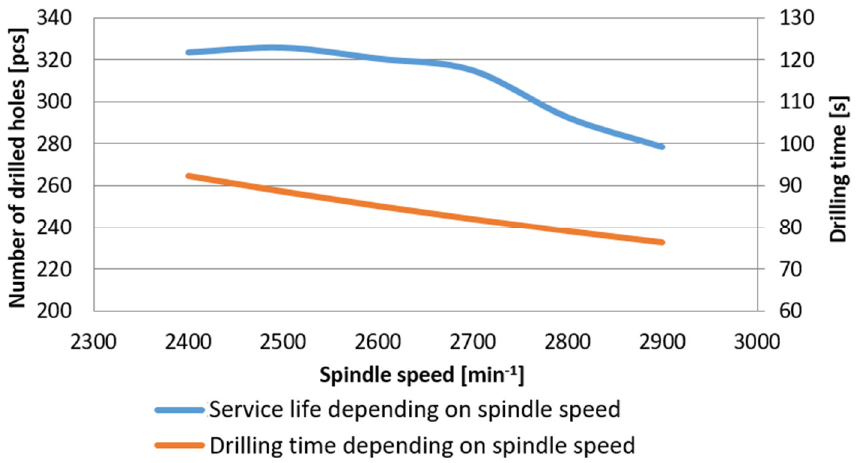
Figure 7. Dependence of the number of holes drilled up to the moment of tool damage on the cutting speed.